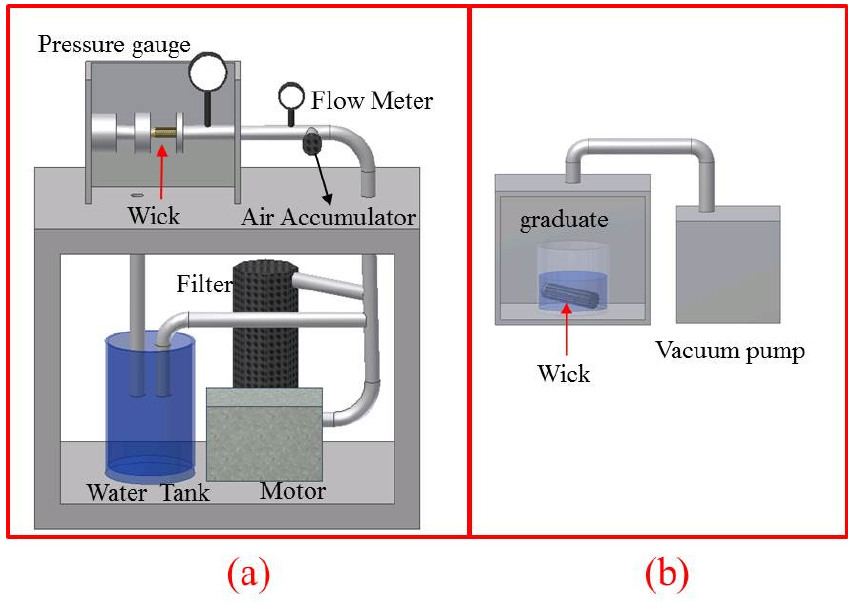
Figure 4. ( a ) Wick parameter measurement platform. ( b ) Porosity measurement.